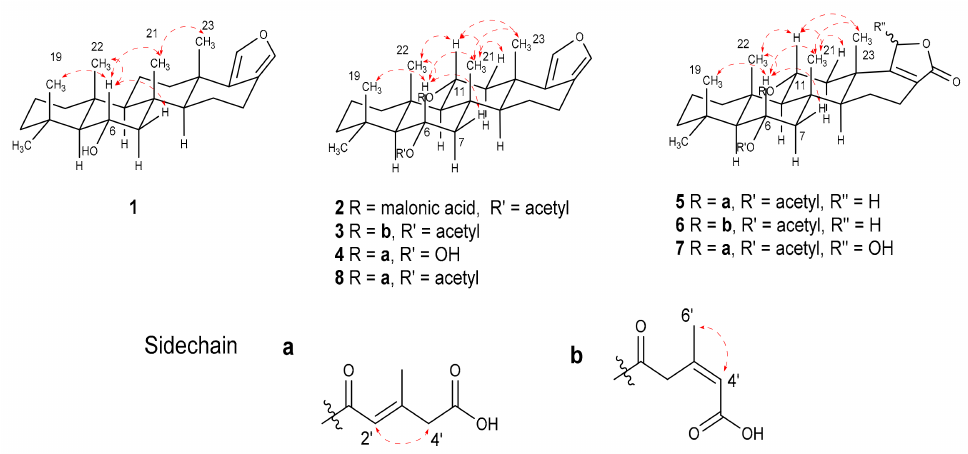
Figure 3. Relevant NOESY correlations (dashed) used to assign the relative stereochemistry of compounds 1 – 8